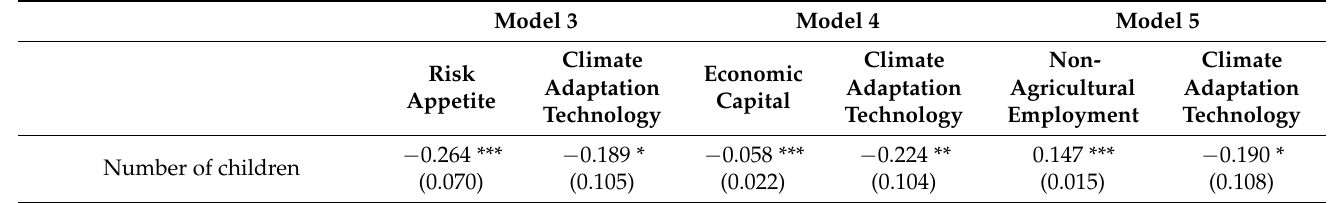
Table 5. Effect mechanism test of the number of children on the adoption of climate adaptive technology by